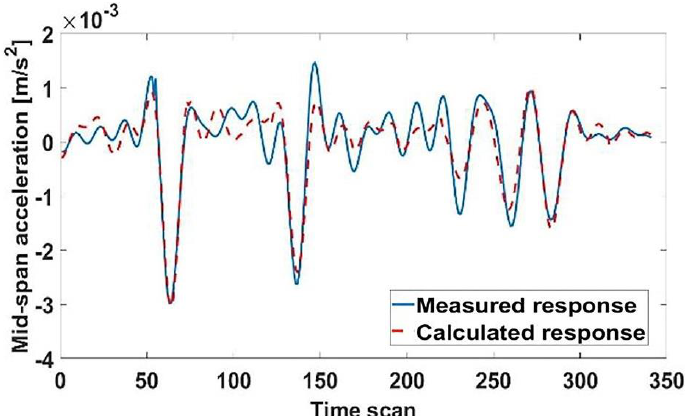
Figure 15. Typical measured bridge acceleration response to a 5-axle truck and corresponding calculated response.